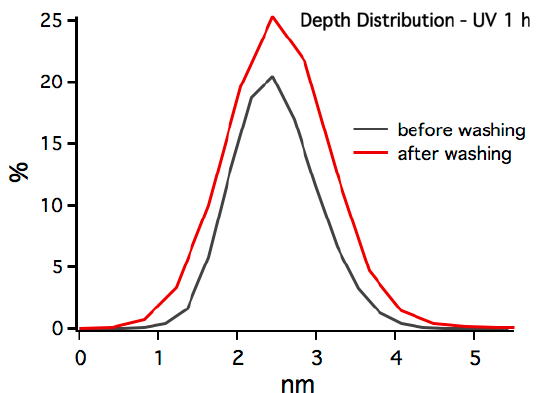
Figure 4. Depth distribution evaluated from the SFM images (Figure 3) before (black curve) and after (red curve) washing the ultra-thin film in ultra-pure water upon UV cleavage for 1 h.